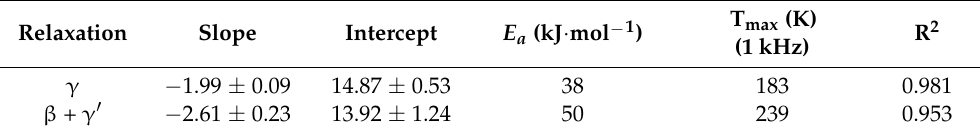
Table 1. Apparent activation energy ( E a ) and temperature peak for CP0.